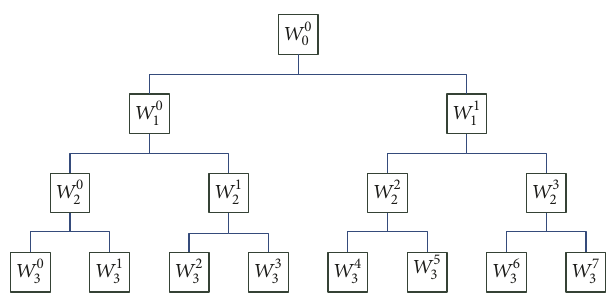
Figure 2: The wavelet packet transform at 2 levels.